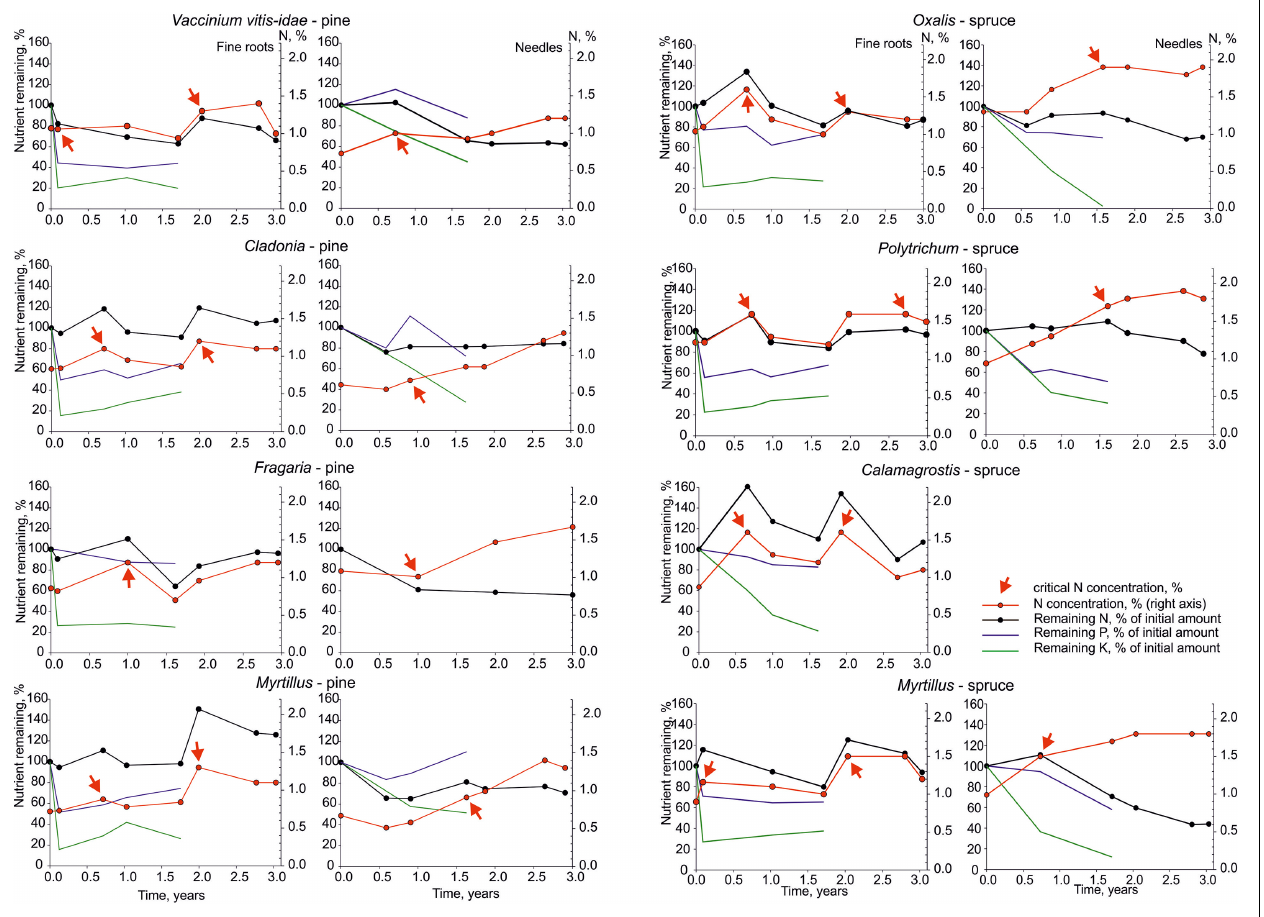
FIGURE 2 | Changes in mass remaining (percentage of initial amount) of nitrogen (N; black line), phosphorus (P; blue line) and potassium (K; green line) in the incubated pine and spruce fine roots and needle litter (left axis). N concentration of the substrate is indicated with red line (right axis) and the critical N concentrations with red